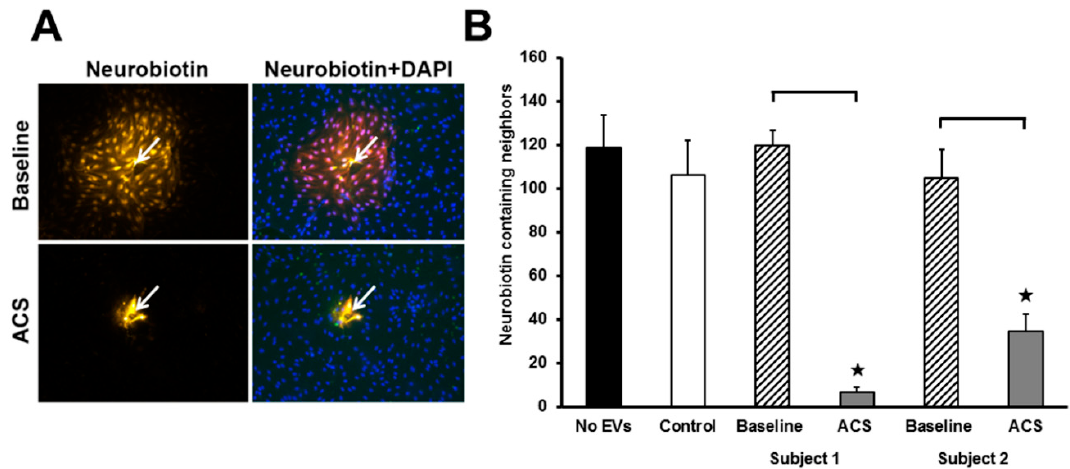
Figure 6. Effect of ACS plasma-derived EVs on the extent of gap junction-mediated intercellular communication. ( A ) Representative photomicrographs of intercellular transfer of Neurobiotin after its injection into a single cell (indicated by arrows) within a monolayer of endothelial cells, treated for 48 h with EVs, isolated at baseline and during an episode of ACS. The Neurobiotin tracer was detected after staining the cells with streptavidin-Cy3 conjugate (yellow). Nuclei were stained with DAPI (blue) to show the locations of all cells. ( B ) Graph shows the quantitation of Neurobiotin transfer experiments (numbers of tracer-containing neighbors) ( n = 6–9 injections for each condition). The ACS EVs caused decreased Neurobiotin transfer to neighboring cells (decreased intercellular communication) ( 🟊 = paired t -test comparing ACS and baseline within SCD subjects, p < 0.05).